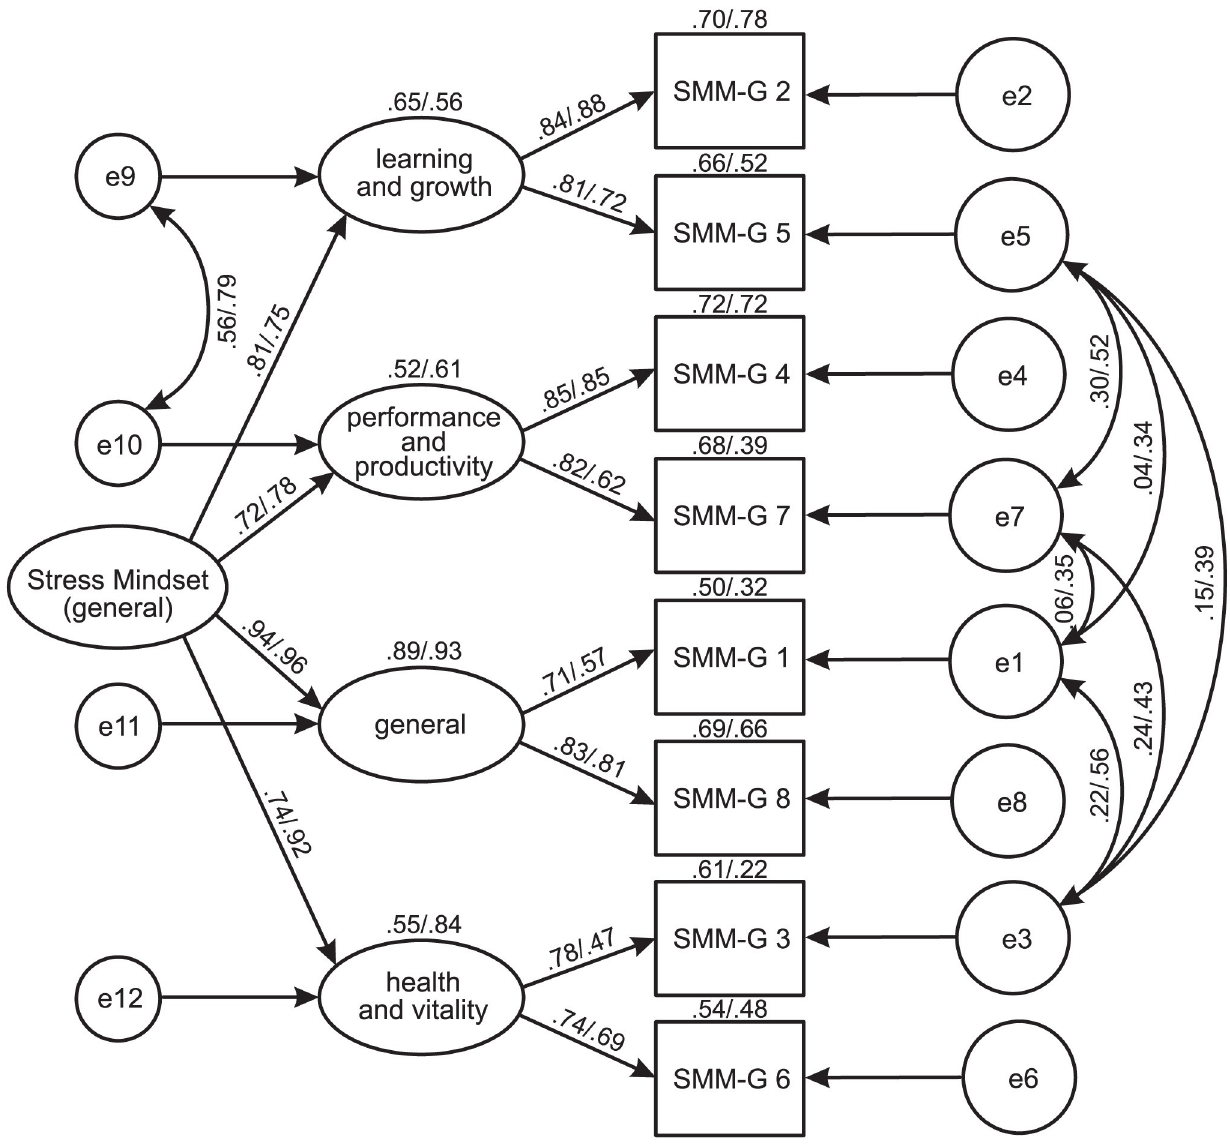
Fig 1. SMM-G: Results of CFA for a hierarchical four-factor model (Study 1 and Study 2, standardized solutions). SMM-G, the Stress Mindset Measure-General ; SMM-G (1–8), items of a scale; Learning and Growth, subscale concerning beliefs of stress consequences for learning and growth; General, subscale concerning beliefs of stress consequences for overall life; Performance and Productivity, subscale concerning beliefs of stress consequences for performance and productivity; Health and Vitality, subscale concerning beliefs of stress consequences for health and vitality; e, residual.